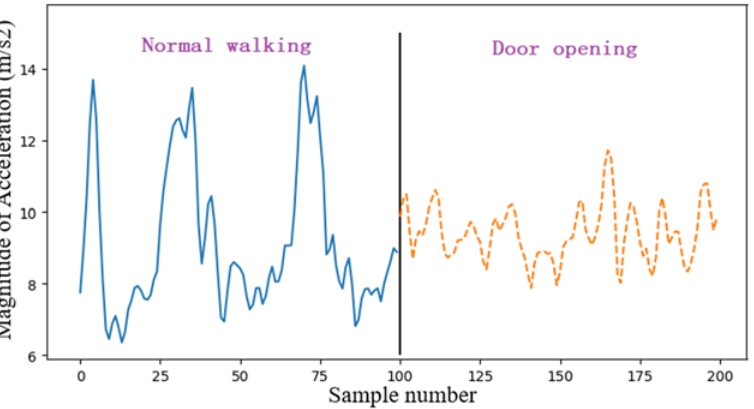
Figure 6. Fluctuation of the magnitude of accelerometer for door opening and normal walking.